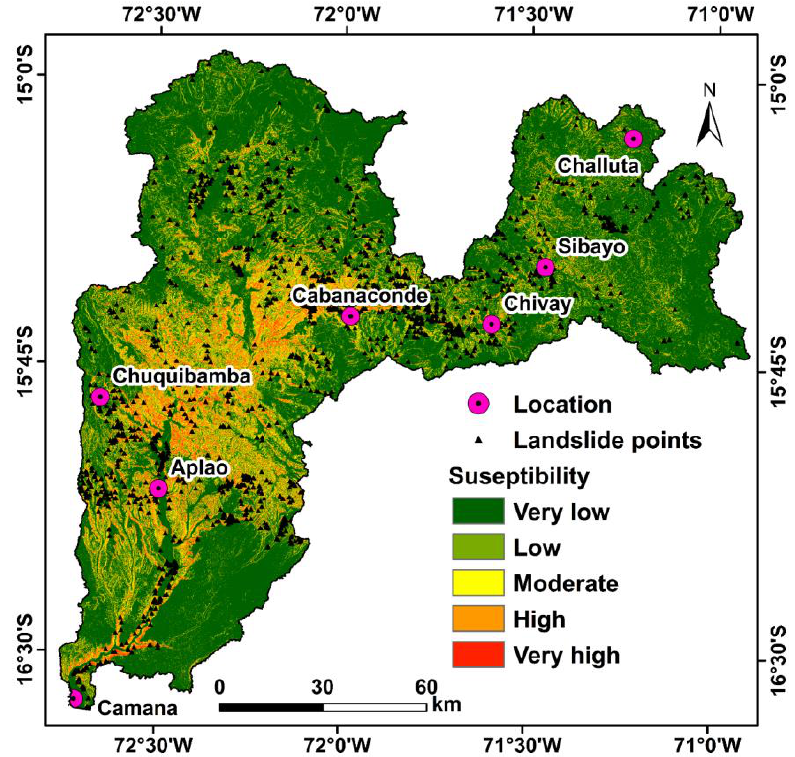
Figure 12. Landslide susceptibility map of the study area derived from KNN + ANN using the top 5 LIFs.